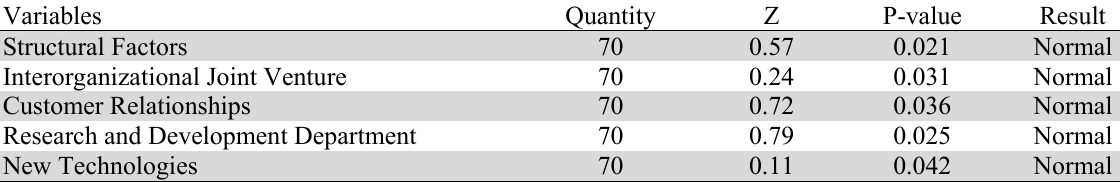
The Kolmogorov-Smirnov Test for Data Normality Variables Quantity Structural